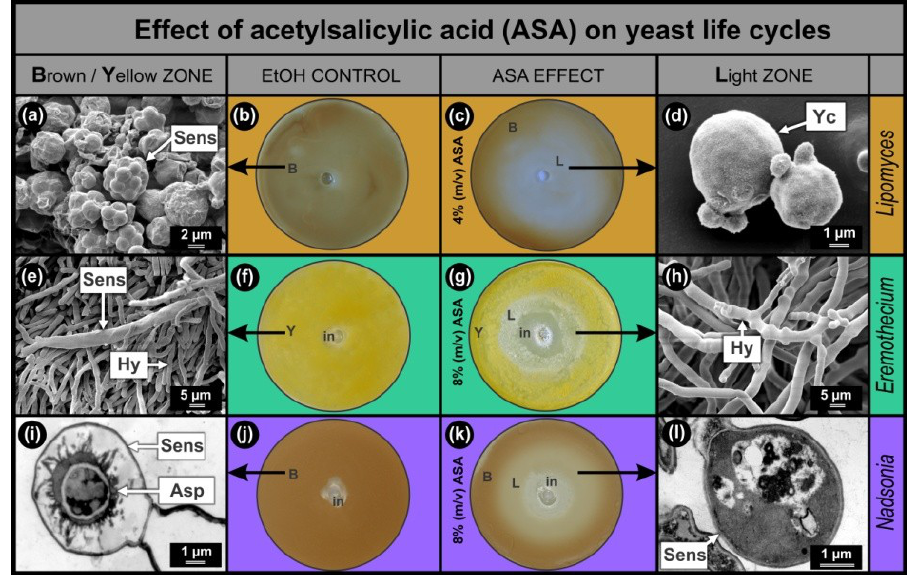
Figure 1. Colour sensors of Lipomyces yamadae, Eremothecium ashbyi and Nadsonia fulvescens sensing ASA. ( a ) SEM micrograph of sensors with ascospores of L. yamadae from brown zone in (b). Brown zone in (c) yielded similar results. ( b ) Control agar plate with brown lawn (due to melanin formation) [5]. The same amount of EtOH added as in (c). ( c ) Bio-assay showing inhibitory effect of ASA on brown pigmented sensor formation (L). ( d ) SEM micrograph of yeasts without sensors in L zone showing selective inhibition of sensors. ( e ) SEM micrograph of yellow sensors of E. ashbyi obtained from yellow lawn in (f). Yellow zone in (g) yielded similar results. ( f ) Control agar plate with yellow lawn (due to Riboflavin) [5]. Same amount of EtOH added as in (g). ( g ) Bio-assay showing inhibitory effect of ASA on sensor formation (L). ( h ) SEM micrograph of hyphae without sensors in L zone showing selective inhibition of sensors. ( i ) TEM micrograph showing sensor structure and ascospore of N. fulvescens observed in brown zone in (j). Brown zone in (k) yielded similar results. ( j ) Control bio-assay with brown lawn (due to melanin) [5,6]. The same amount of EtOH added as in (k). ( k ) Bio-assay showing inhibitory effect of ASA on sensor formation (Light zone-L). ( l ) TEM micrograph of sensor containing a malformed ascospore in L zone showing selective inhibition. Images of Nadsonia (i,l) were taken with permission from [8,9]. Parts of this figure are available as a video lecture [5]. ASA, Acetylsalicylic acid; Asp, ascospore; B, brown zone; Hy, hyphae; in, inhibition zone; L, light zone; Sens, sensor; Y, yellow zone; Yc, yeast